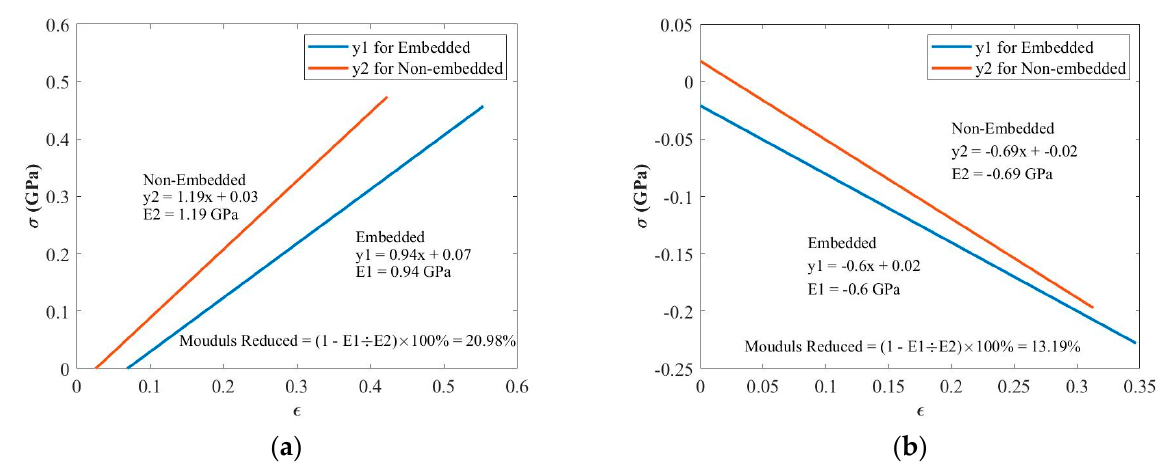
Figure 11. Mechanical properties studies for ( a ) tensile and ( b ) compressive modulus reductions compared to composite coupons without embedded PZT transducers.